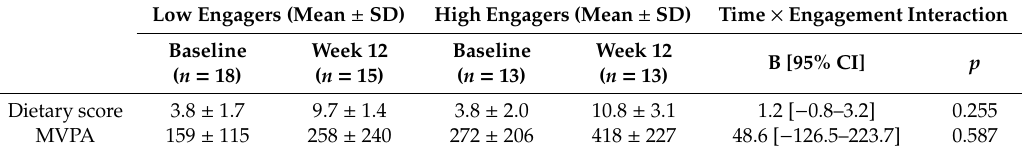
Table 1. Descriptive statistics and results from linear mixed models examining the association between engagement with Paola and change in dietary adherence score and moderate-to-vigorous physical activity (MVPA) from baseline to week 12. Low Engagers (Mean ± SD) High Engagers (Mean ± SD) Time × Engagement Interaction Baseline Week 12 Baseline Week 12 B [95% CI] p ( n = 18) ( n = 15) ( n = 13) ( n = 13) Dietary score 3.8 ± 1.7 9.7 ± 1.4 3.8 ± 2.0 10.8 ± 3.1 1.2 [ − 0.8–3.2] 0.255 MVPA 159 ± 115 258 ± 240 272 ± 206 418 ± 227 48.6 [ − 126.5–223.7] 0.587 B = Beta coe ffi cient, 95% CI = confidence